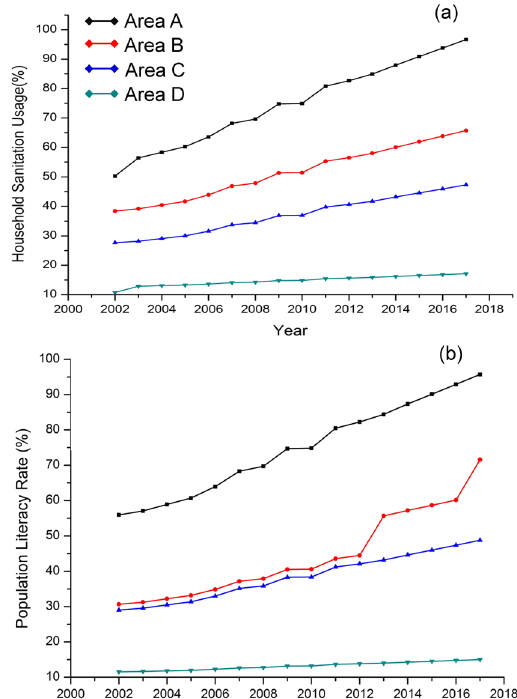
Figure 4. Temporal trends of ( a ) Household Sanitation usage (SANu) and ( b ) Literacy rate (Lt) as percentage of population in the detailed study areas A through